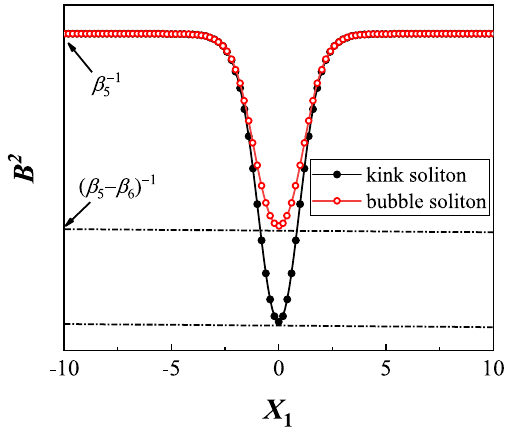
Figure 6. Sketch for the profiles of kink and bubble